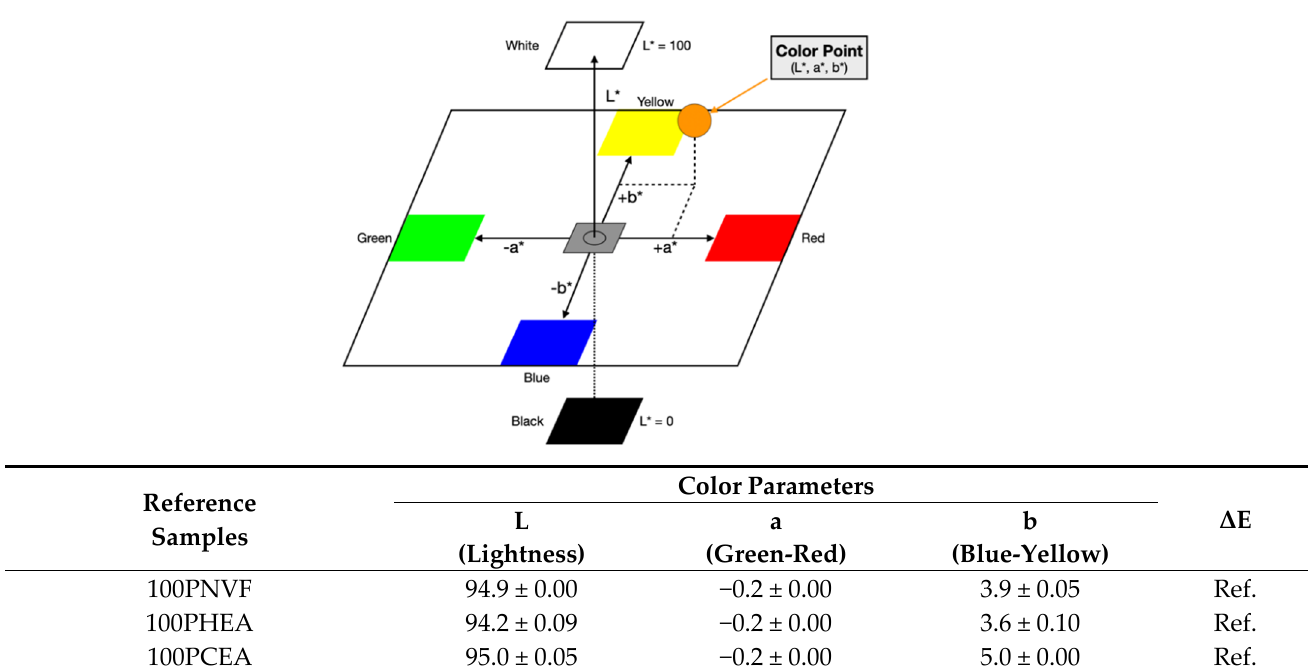
Figure 4. Color parameter measurements are based on the three-dimensional CIE color space; the table shows the total color difference parameter of reference homopolymer hydrogels.